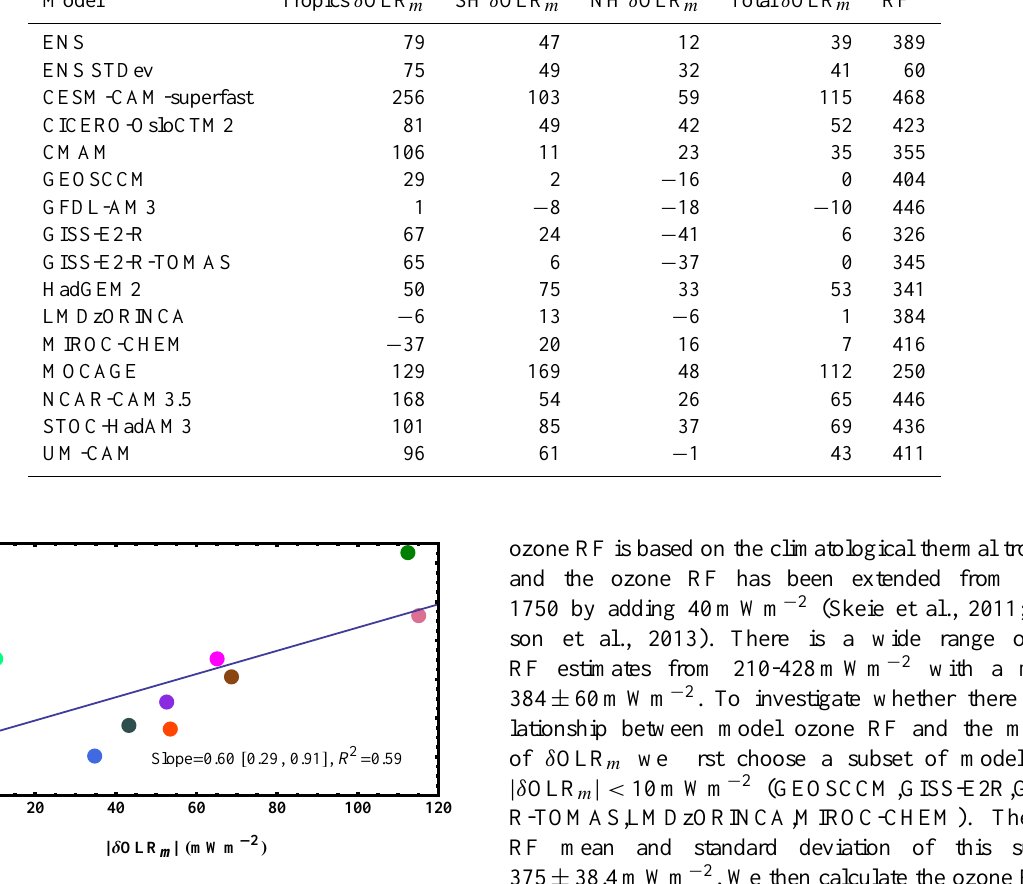
Fig. 7. The deviation of ACCMIP ozone radiative forcing from an ensemble mean versus | δ OLR m | , which is the magnitude of the difference between model ozone and TES ozone weighted by the TES Instantaneous Radiative Kernel. The mean is calculate from an subset of models whose | δ OLR m | < 10mWm − 2 . The δ OLR is integrated through the TES diagnosed chemical tropopause q = 150ppb and averaged from 2005-2010. The correspondence be- tween the colors and models is the same as in Fig. 6. The brackets for the slope represent the uncertainty at the 95%